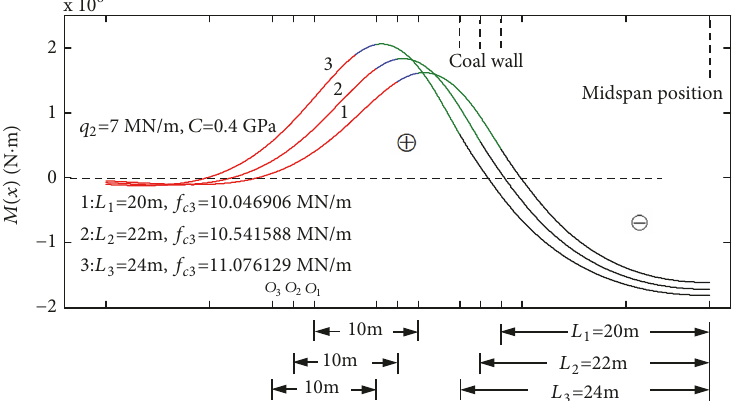
Figure 14: Bending moment curves of rock beam with the increasing of the distance of overhang roof.